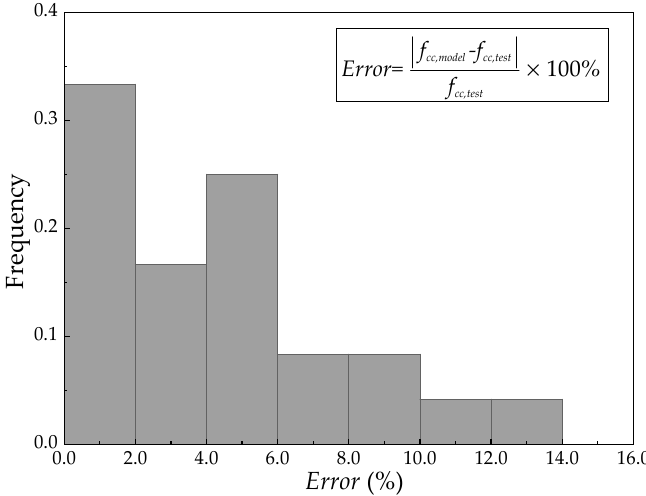
Figure 20. Frequency statistics of the relative error between model calculated f cc and tested f cc From Figures 19 and 20, the calculated peak stress is slightly lower than the test value, and the relative error is within 10%, which accounts for 92% of the test data. Considering